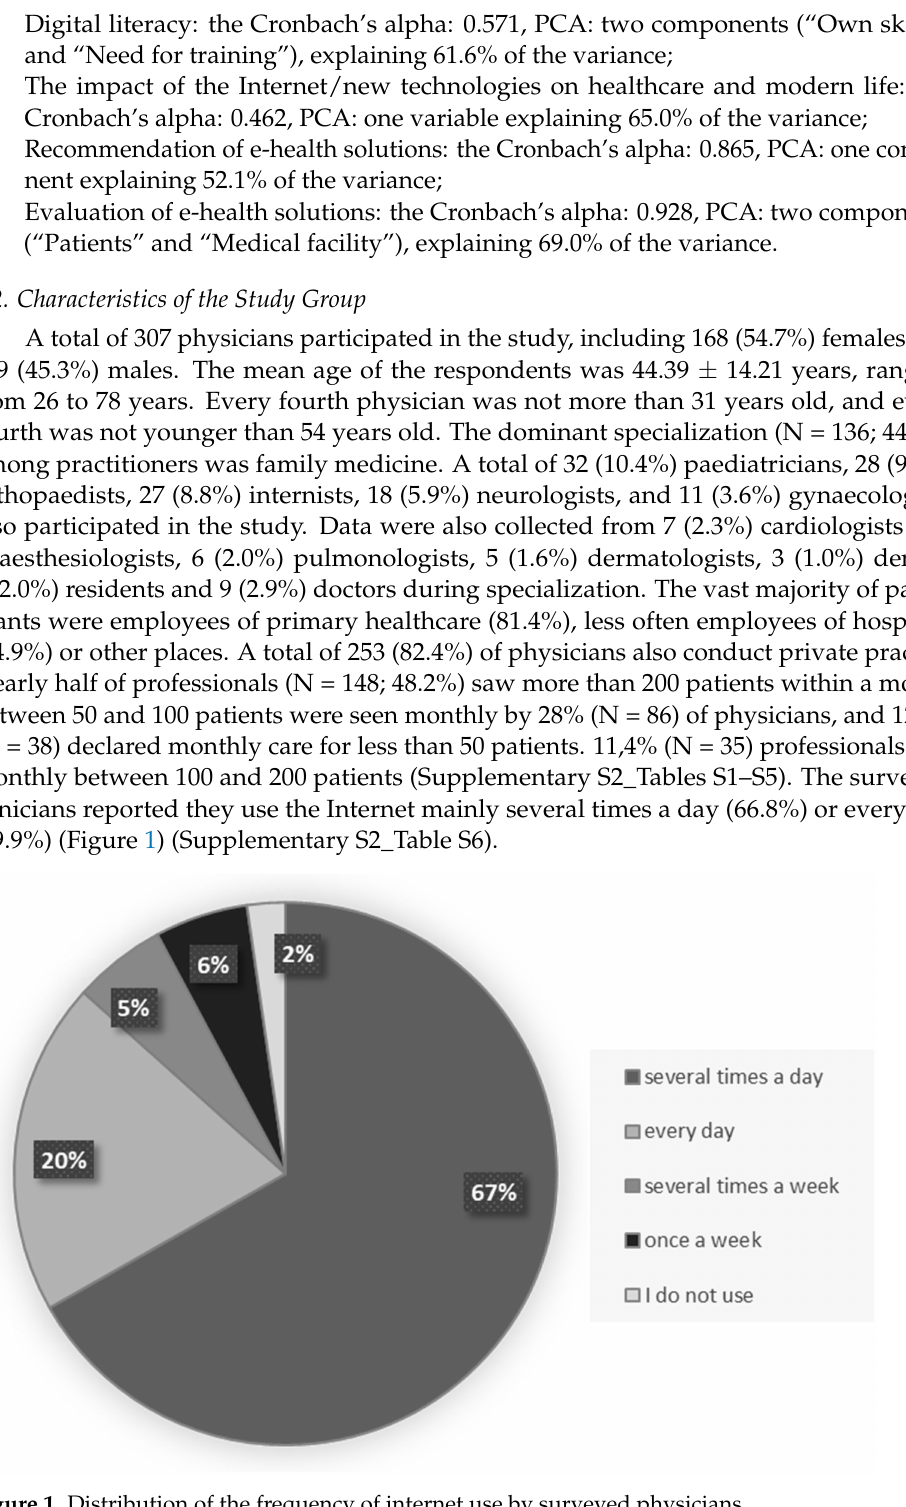
Figure 1. Distribution of the frequency of internet use by surveyed